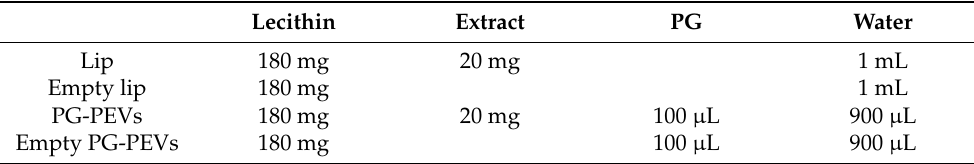
Table 1. Composition of the P. spinosa fruit extract nanoformulations.